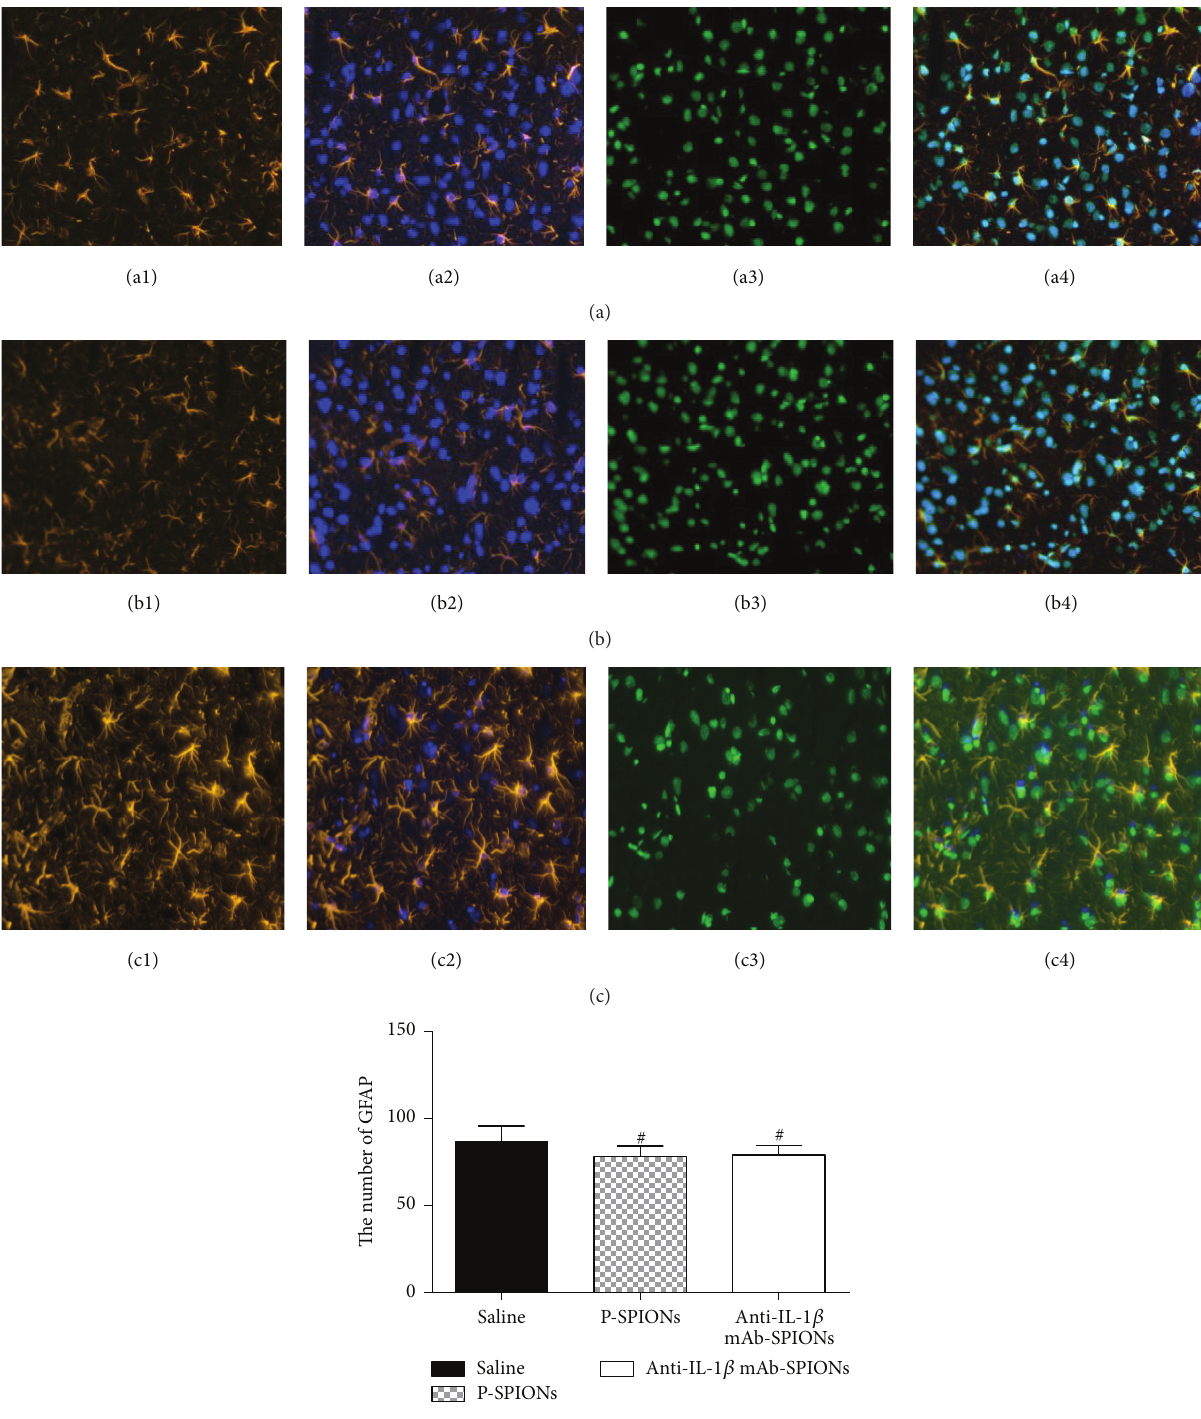
Figure 5: NF-kappa B p65 expression and astrocyte hyperplasia in the hippocampus CA3 of epileptic rats treated with anti-IL-1 𝛽 mAb- SPIONs versus saline and P-SPIONs (20x); ((a1)–(b4)) show the activation of GFAP-positive astrocytes and the expression of NF-kappa B p65 in astrocyte nucleus was observed in the saline ((a1)–(a4)) and P-SPIONs groups ((b1)–(b4)). Colocalization panels ((a4)–(c4)) show NF- 𝜅 B p65 expression in activated astrocytes in the hippocampus CA3 of epileptic rats; (c4) notes the inhibition of NF- 𝜅 B p65 nucleus transfer in anti-IL-1 𝛽 mAb-SPIONS-treated rats; (c1) shows that the astrocytes still have an activated phenotype. (d) shows the number of positive-GFAP astrocytes (mean ± SD, 𝑛 = 10 ). # 𝑃 > 0.05 versus saline